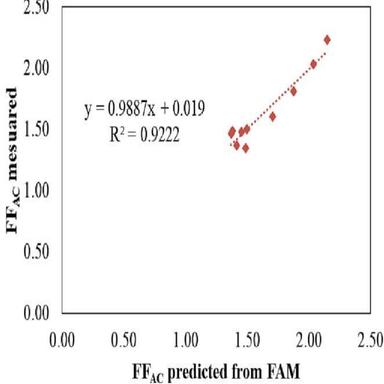
Relationship between the FFAC measured and predicted from the FAM data using a power law equation.